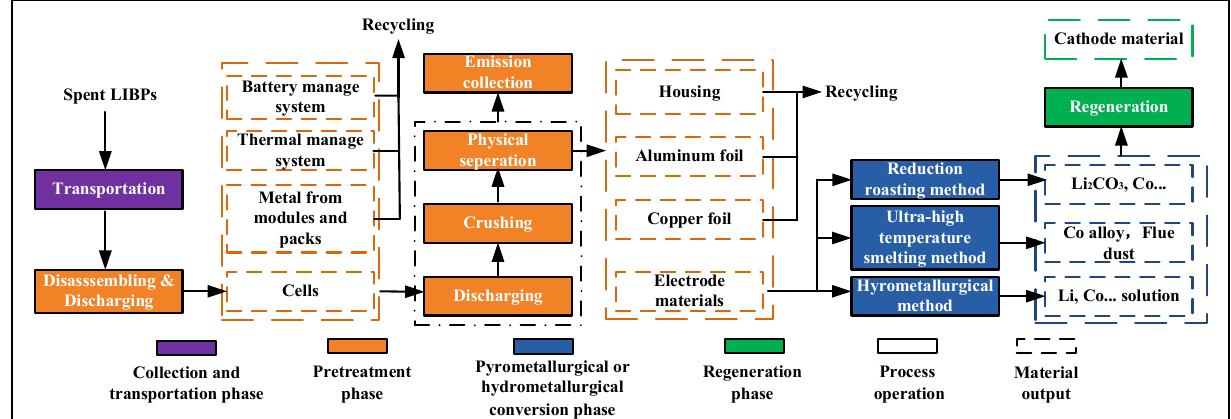
Figure 4. System boundary of spent LIB recycling used in this study.